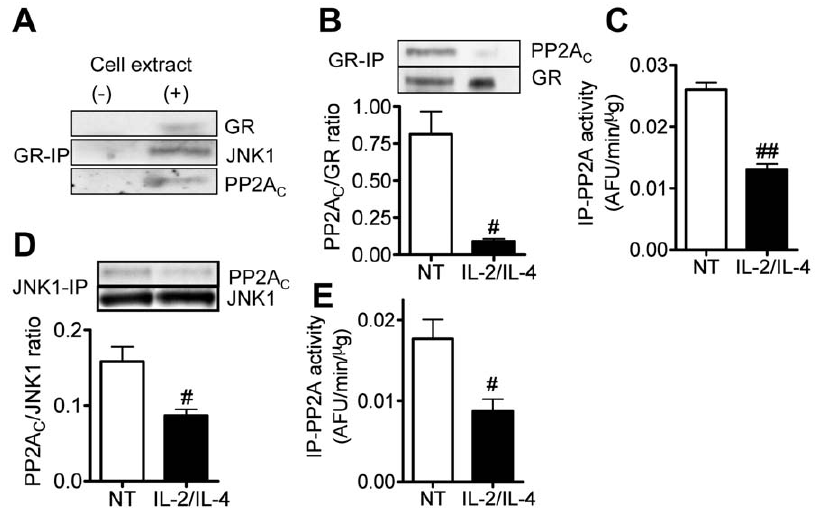
Figure 4. Association between PP2A and GR/JNK1 in U937 cells. (A) PP2A C and JNK1 expression in GR-immunoprecipitates. Expression levels of PP2A C in GR (B)- or JNK1 (D)-immunoprecipitates. PP2A activity in GR (C)- and JNK1 (E) immunoprecipitates were also determined. Values represent means of four experiments 6 SEM. # P , 0.05, ## P , 0.01 (vs. non-treatment control; NT).